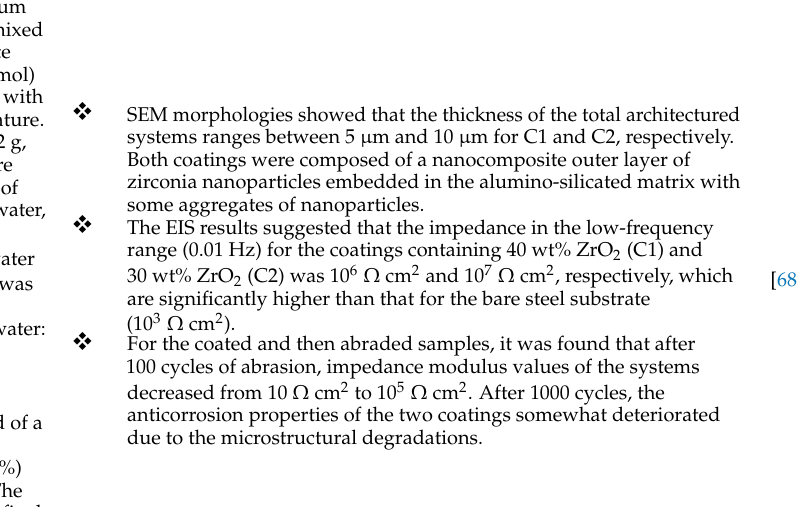
Table 1. Different approaches for improving silane coatings and the main findings, as reported in the literature.